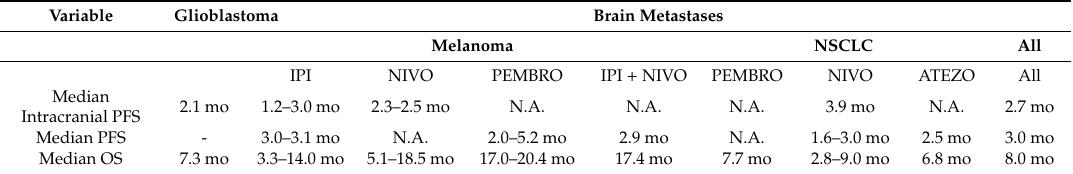
Table 3. Median survival outcomes of immune checkpoint inhibitors in patients with glioblastoma or brain